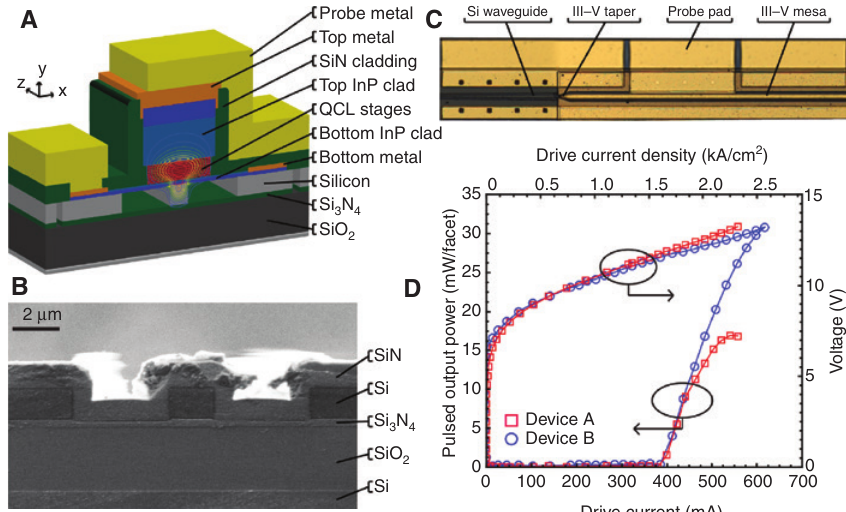
Figure 4: QCLs heterogeneously integrated on Si. (A) Schematic diagram showing the structure of the active region of a heterogeneously integrated QCL, (B) SEM image of a polished SONOI waveguide facet, (C) top-view micrograph of the device, (D) output power and applied voltage versus drive current measured in two devices [72] (© 2016 Optical Society of